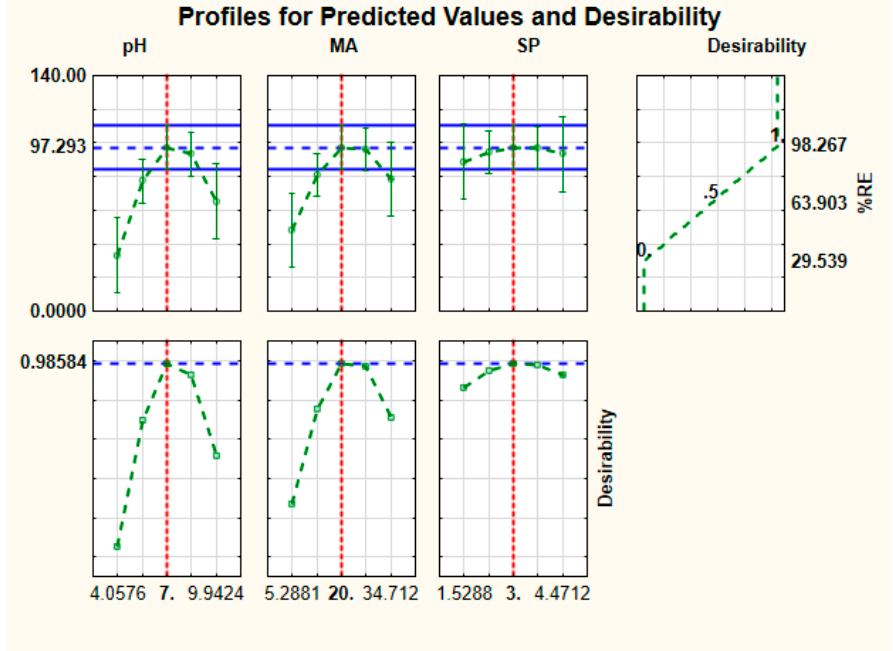
Figure 6. Profiles for predicated values and desirability function for removal of fluoroquinolones.